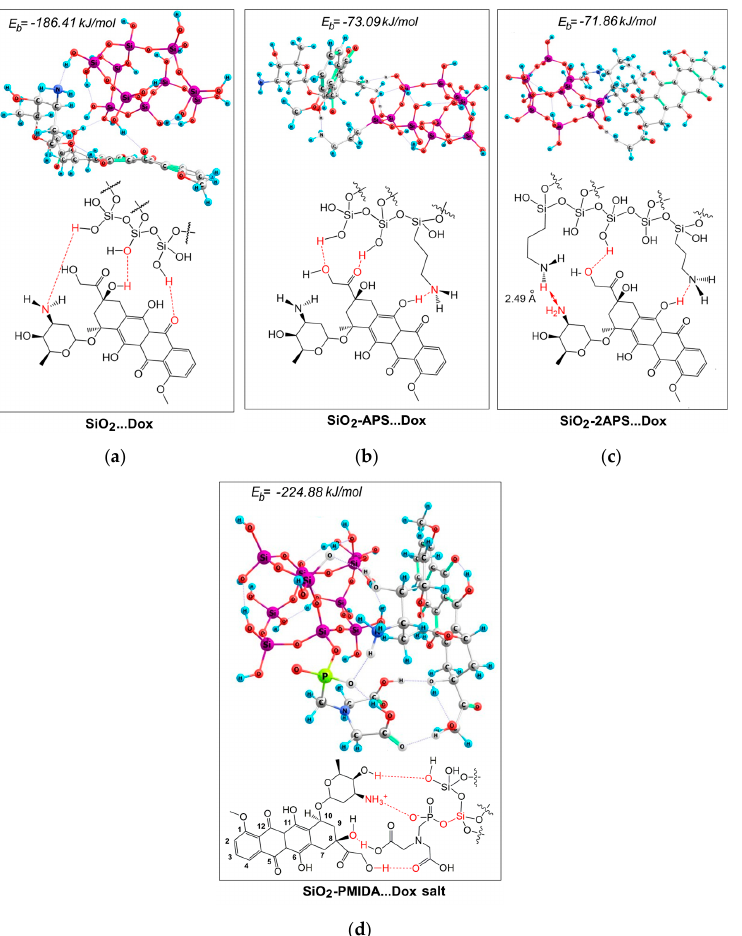
Figure 7. Images of Dox complexes with ( a ) SiO 2 cluster, ( b ) SiO 2 -APS, ( c ) SiO 2 -2APS and ( d ) SiO 2 -PMIDA. The binding energies ( E b ) were calculated at the B3LYP-D3-gCP/def2-SVP level of theory in water using ORCA 4.0.1 software [57]. The atoms involved in the binding of molecules on the cluster surface are highlighted in red. This may indicate the strongest binding of Dox to the surface of NCs containing SiO 2 and PMIDA fragments. Dox coordination in the SiO 2 -PMIDA…Dox complex (Figure 7d) occurs due to the formation of various bonds: an ionic bond between the Dox amino